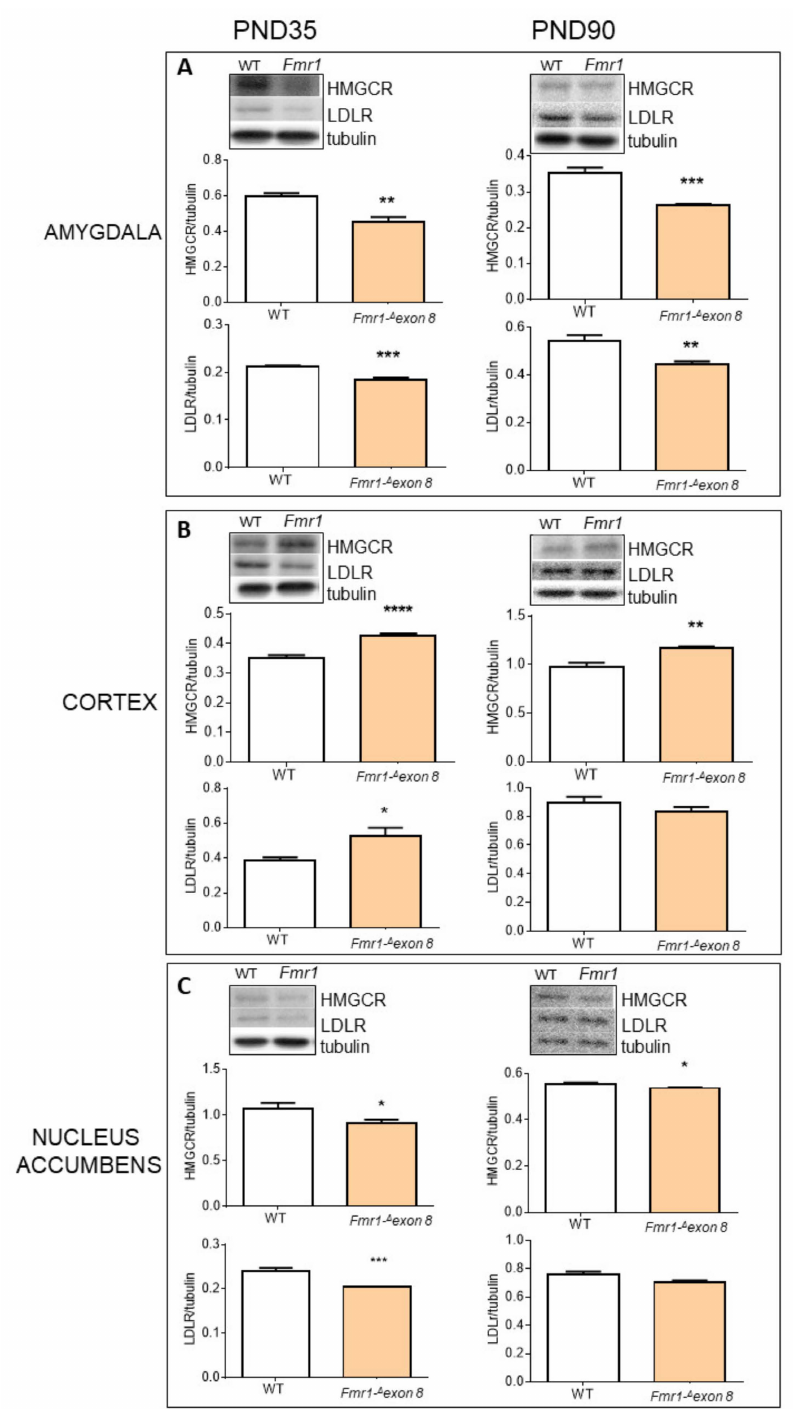
Figure 4. HMGCR and LDLR protein level in brain areas of Fmr1- ∆ exon 8 and WT male adolescent (PND35) and adult (PND90) rats. ( A ) illustrates a typical Western blot (top) and the densitometric analysis of HMGCR and LDLR in the amygdala of PND35 and PND90 rats. ( B ) illustrates a typical Western blot (top) and the densitometric analyses of HMGCR and LDLR in the prefrontal cortex (CORTEX) of PND35 and PND90 rats. ( C ) illustrates a typical Western blot (top) and the densitometric analyses of HMGCR and LDLR in nucleus accumbens of PND35 and PND90 rats. Tubulin served as a housekeeping protein to normalize protein loading. Values represent mean ± SD obtained from 6 animals performed in duplicate. Statistical analysis was carried out by using the unpaired Student’s t -test. * = p < 0.05 vs. WT; ** = p < 0.01 vs. WT; *** = p < 0.001 vs. WT; **** = p < 0.0001 vs.